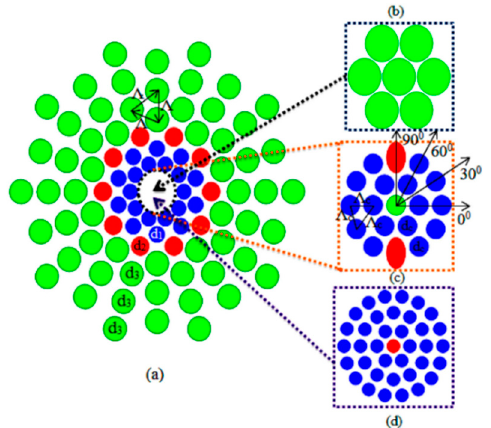
Figure 6 . (a) Overall structural view of the proposed spiral HC-PCF. The cladding is formed with spiral shape that contains circular air holes; (b) air hole details of the first spiral ring of the core S-PCF; (c) details of the circular structure of the cluster in the core region which are formed into a microstructure shape; (d) core region magnification of the enlarged end face view of the suggested S-PCF. Reprinted with permission from [73].